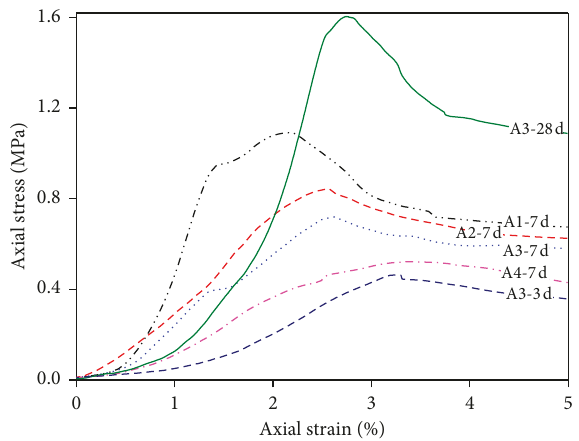
Figure 8: Stress-strain curves at the curing time of 7d of Group A and at the curing times of 3 d and 28d of Group A3.